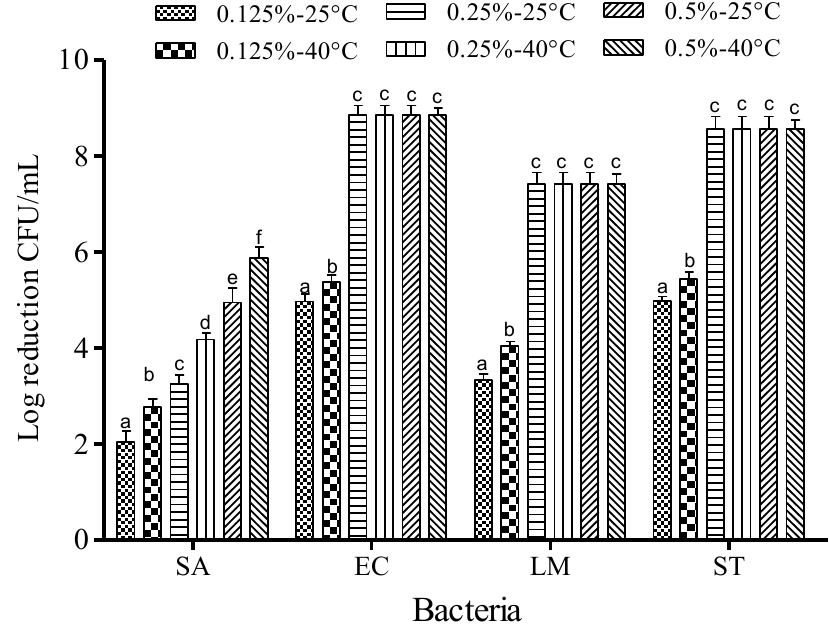
Figure 3. Inactivation of different foodborne pathogens treated with fumaric acid at different concentrations and temperatures for 1 min. Vertical bars represent means of three replications ± standard deviation. Bars labeled with different letters indicate significant differences at p < 0.05. SA: S. aureus , EC: E. coli O157:H7, LM: L. monocytogenes , ST: S. Typhimurium . The initial level of each foodborne pathogen was 8.86, 7.68, 7.43, and 8.56 for EC, SA, LM, and ST,